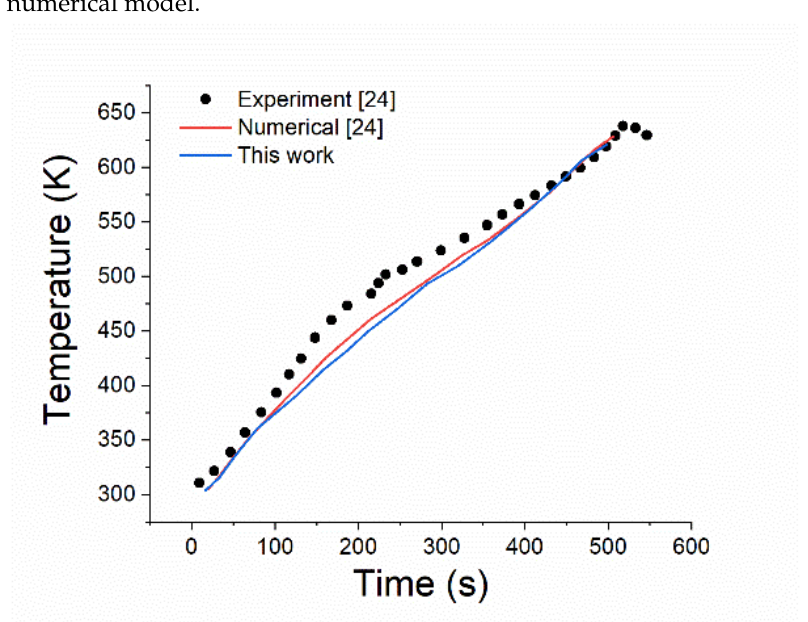
Figure 2. Physical geometry and computational mesh. Figure 2. Validation of the numerical